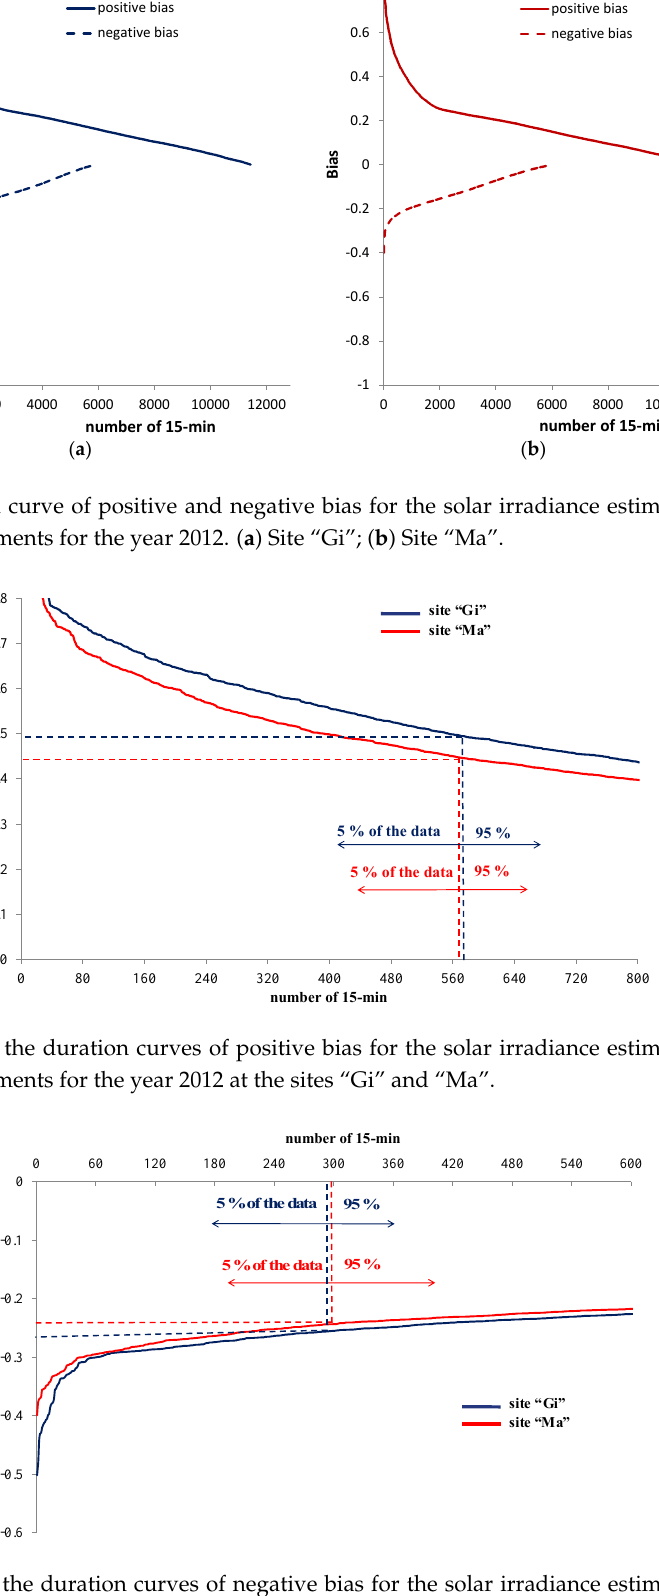
Figure 10. Duration curve of the absolute errors for the solar irradiance estimated data with respect to measurements for the year 2012. 0 0.10.20.30.40.50.60.70.8 0 site “ Gi ” site “Ma” Figure 11. Zoom of the duration curves of the absolute error for the solar irradiance estimated data with respect to measurements for the year 2012 at the sites “Gi” and “Ma”.